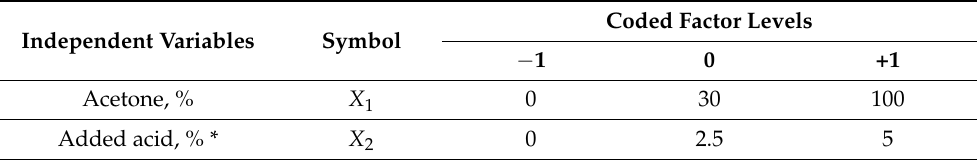
Table 5. Independent variables and their levels used in the response surface design.